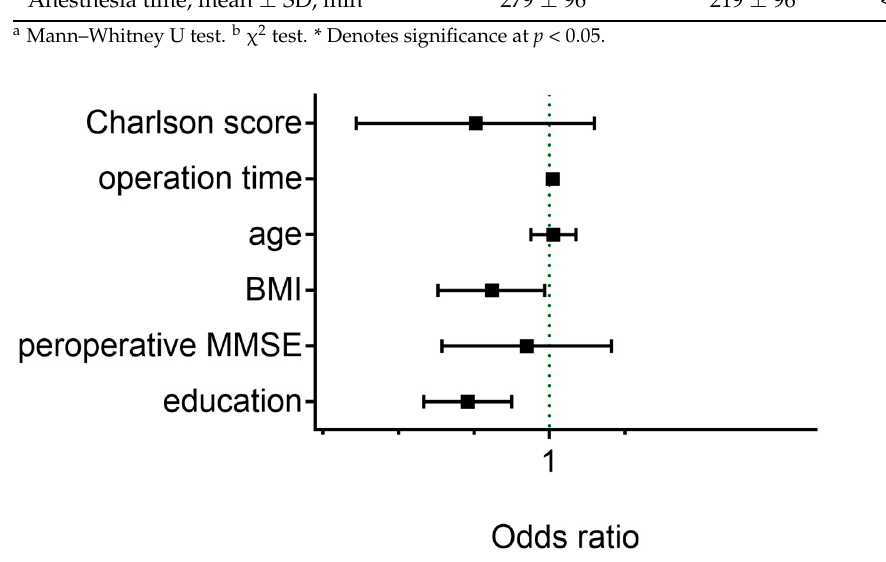
Figure 2. Odds ratios for emergence delirium (ED) with 95% confidence intervals.